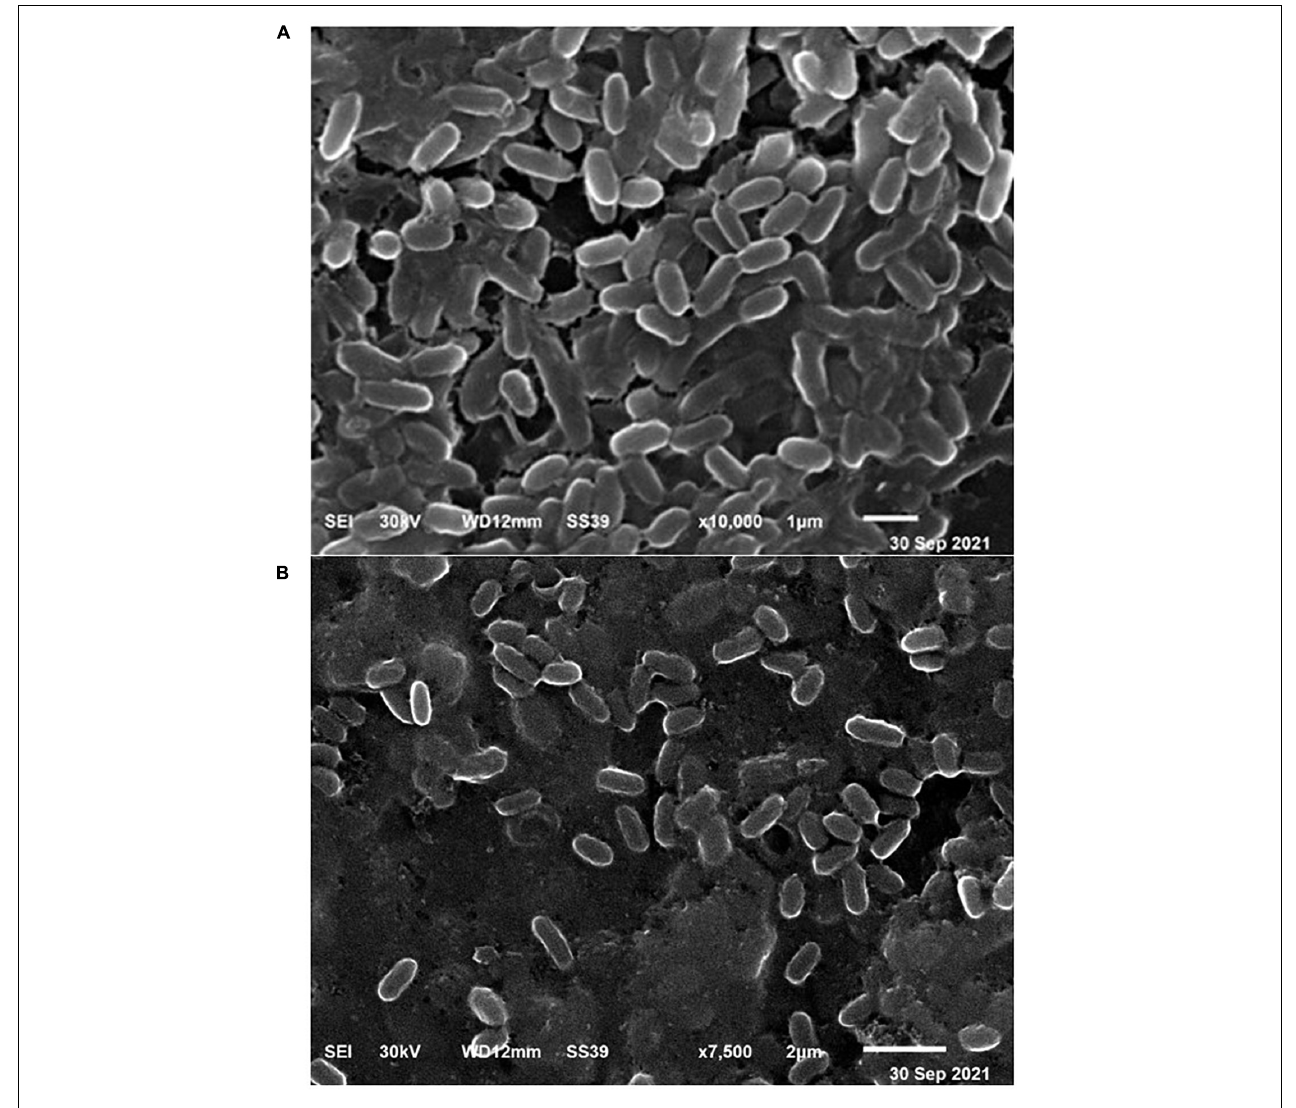
FIGURE 6 | Micrograph of scanning electron microscopy, viewing the normal cells of P. alcaliphila NEWG-2 (A) before and (B) after biosorption process of Co